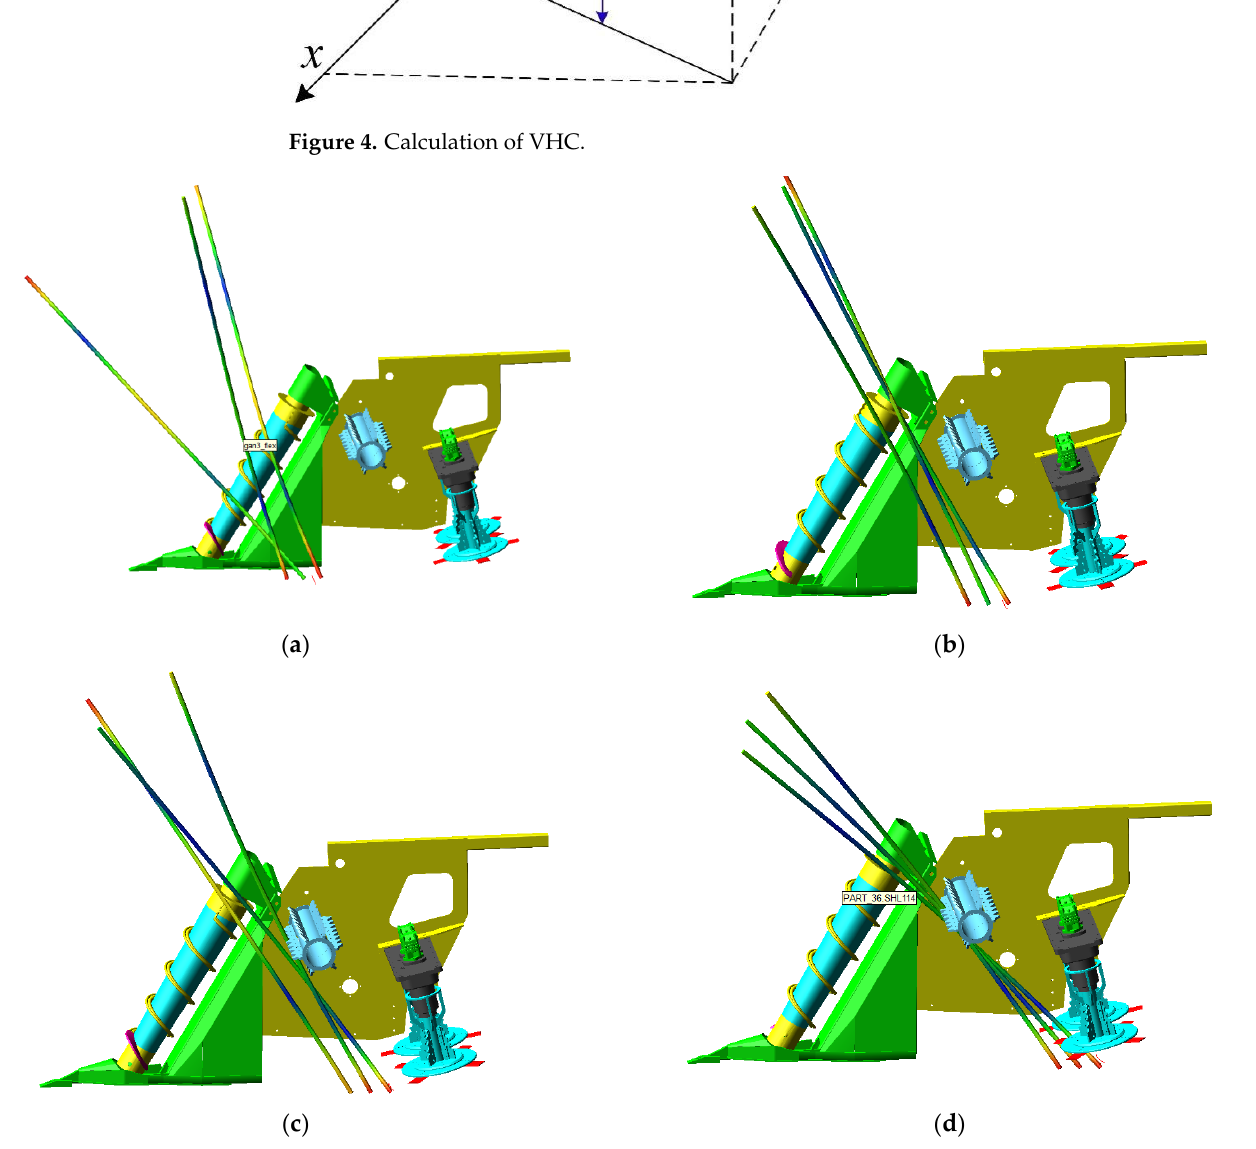
Figure 5. Movement characteristics of lodged sugarcane during lifting. ( a ) Lodging sugarcane is lifted; ( b ) Lift to the top of the drum; ( c ) Gather at top; ( d ) Contact between root and blade.